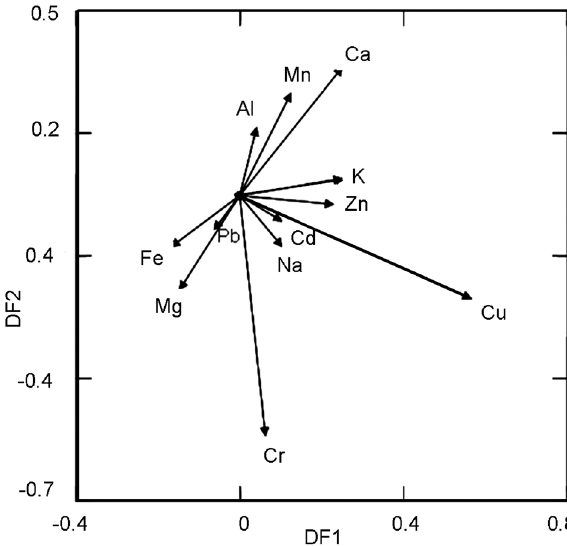
Fig. 7. – Contribution of cuttlebone chemistry elements to the discriminant functions. Vectors indicate the loadings of the scores for each variable on the first two discriminant